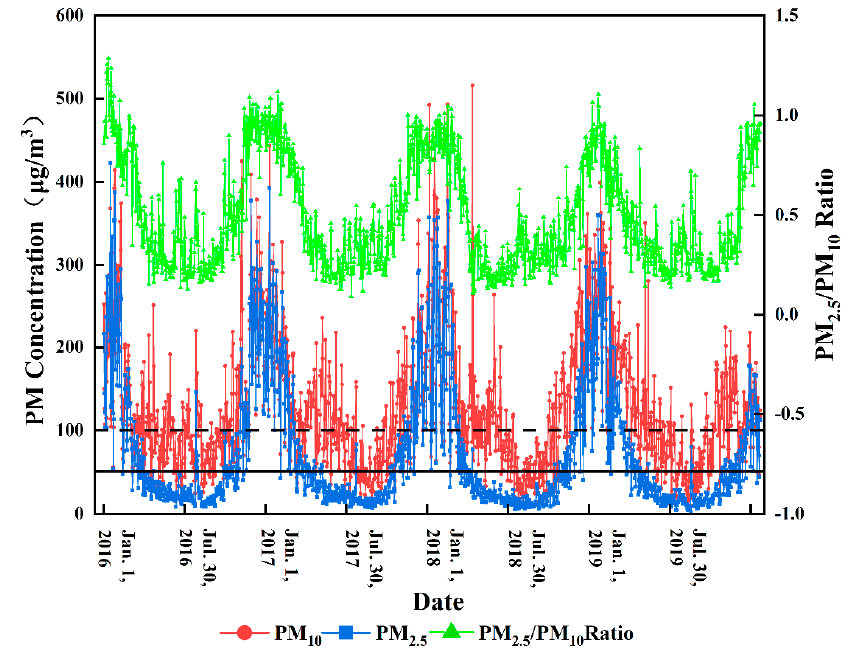
Figure 4. Daily average PM concentrations and PM 2.5 /PM 10 ratios recorded from 2016 to 2019. The solid and dashed lines represent the 24 h limits for PM 2.5 and PM 10 , respectively.